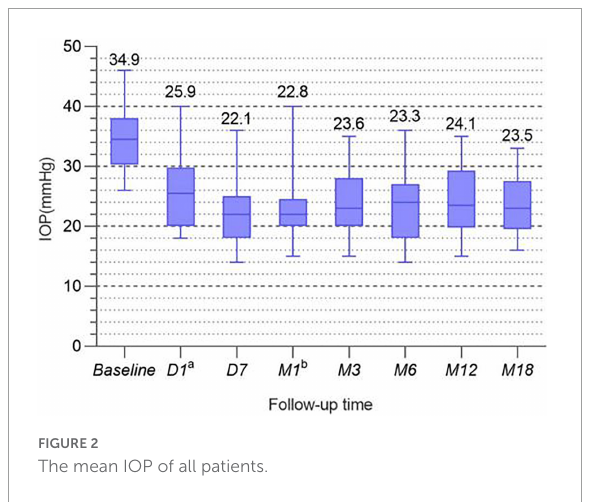
FIGURE2 The mean IOP of all patients.